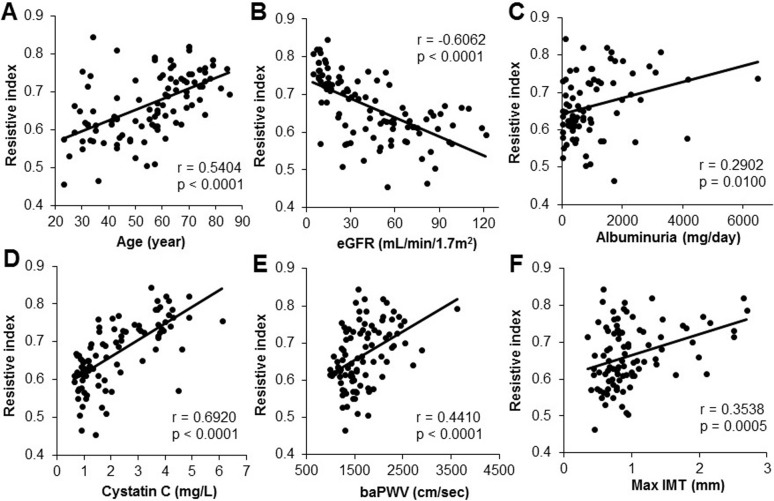
The correlation between the resistive index (RI) and various parameters.The relationships between the RI and patient age (years) (A), estimated glomerular filtration rate (eGFR) (mL/min/1.73 m2) (B), albuminuria (mg/day) (C), cystatin C (mg/L) (D) and markers of systemic atherosclerosis, including the ankle-brachial pulse wave velocity (baPWV) (E) and maximum intima-media thickness (IMT) (F), are shown. The RI was positively correlated with age, albuminuria, and cystatin C, and inversely correlated with eGFR (A-D). Regarding the markers of systemic atherosclerosis, baPWV and maximum IMT were positively correlated with RI (E, F).